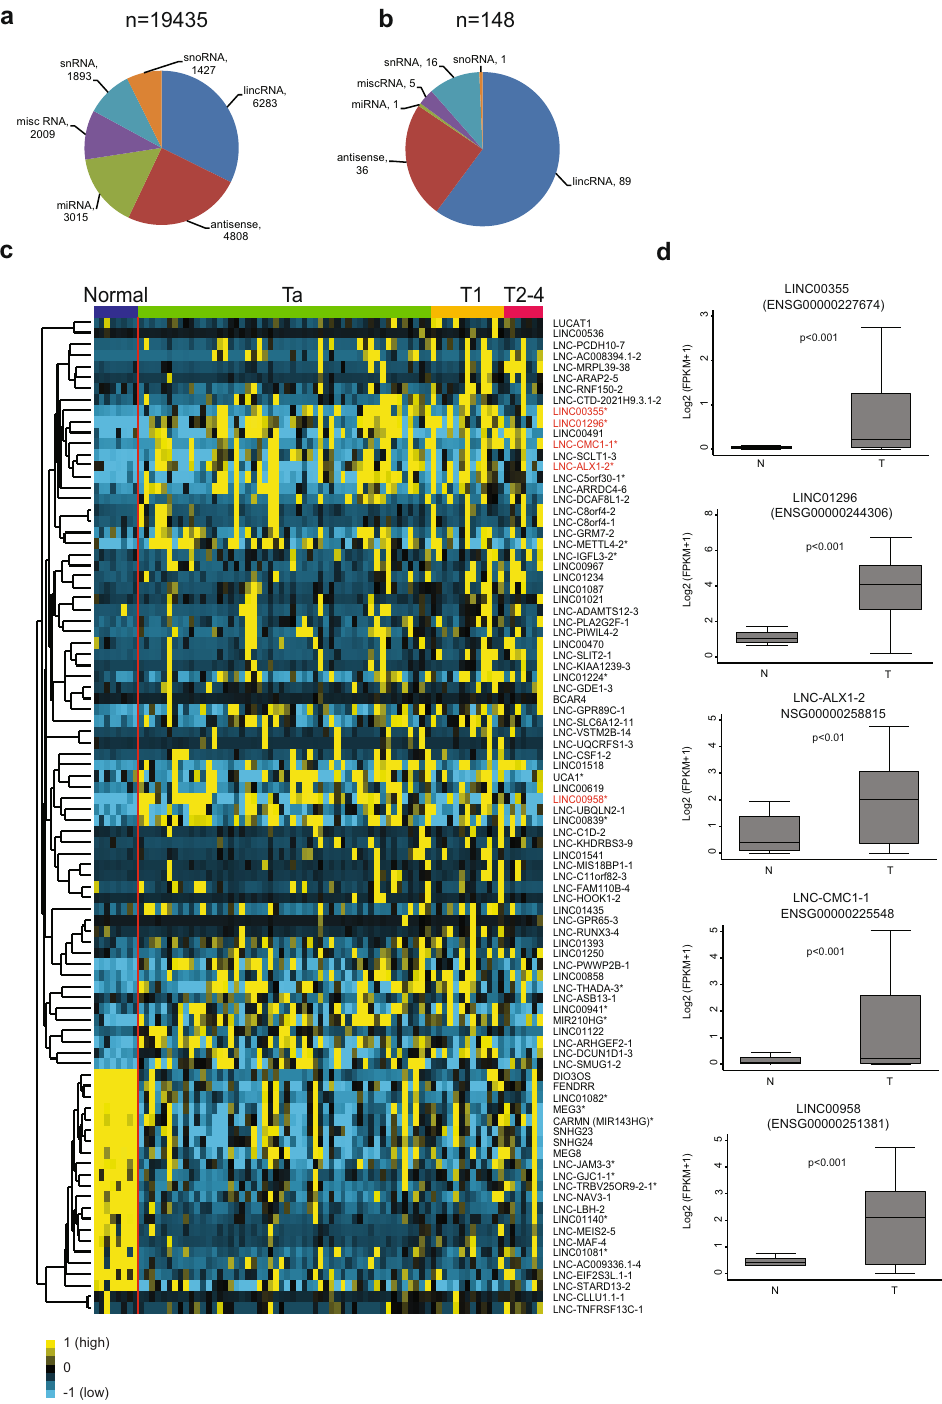
Figure 1. Non-protein coding RNA expression in bladder cancer. ( a ) Overall biotype distribution of non- protein coding transcript (i.e. lincRNAs, antisense RNAs, miRNAs, snoRNAs, snRNAs and miscRNAs) identified using Cufflinks and Cuffmerge and annotated according to Gencode v19. ( b ) Biotype distribution of the significantly differentially expressed non-protein coding genes using CuffDiff analysis. ( c ) Heat map of 89 significantly differentially expressed lincRNAs between normal urothelium and BC. Rows represent individual lincRNAs, columns represent individual tissue samples (sorted according to tumor stage as indicated). Yellow indicates up-regulation and blue indicates down-regulation. Genes are mean centered (black color) and normalized. LincRNAs selected for functional characterization are highlighted in red. * LncRNAs up/down regulated in the TCGA dataset (FC log2 > 0.15 or <− 0.15, p < 0.01). ( d ) The expression of the five selected lincRNAs in normal (n = 8) urothelium compared to BCs (n = 72). Significance was tested using Student’s t -test. FPKM: Fragment Per Kilobase of exon per Million mapped